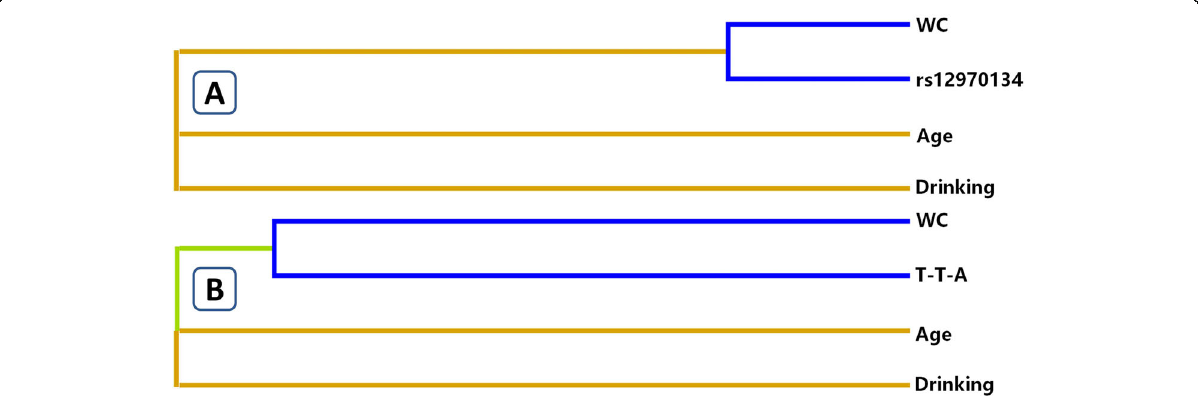
Fig. 2 Different types of interaction dendrogram for SNP-environment ( a ) and haplotype-environment ( b ) interactions on the risk of obesity. Blue color, strong redundancy interaction; green color, weak redundancy interaction; orange color, synergy. The elements with strong interaction are close to each other at the leaves of tree, and the elements with weak interaction are far away from each other